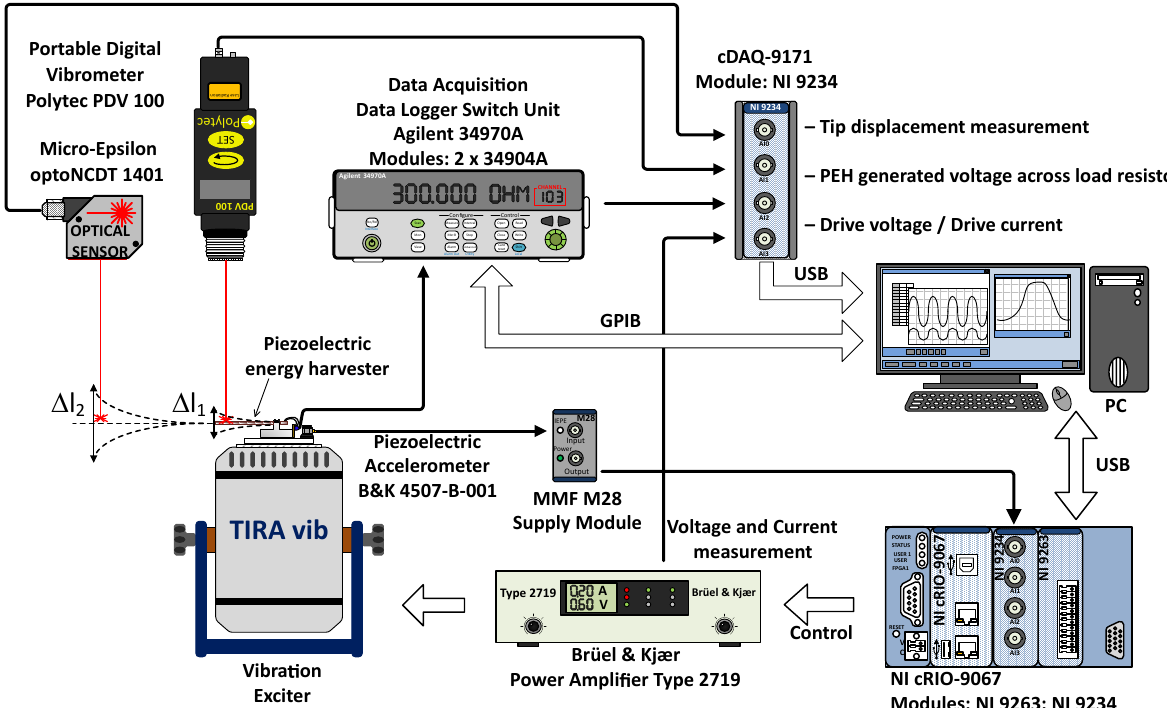
Figure 3. The system used to measure the power and